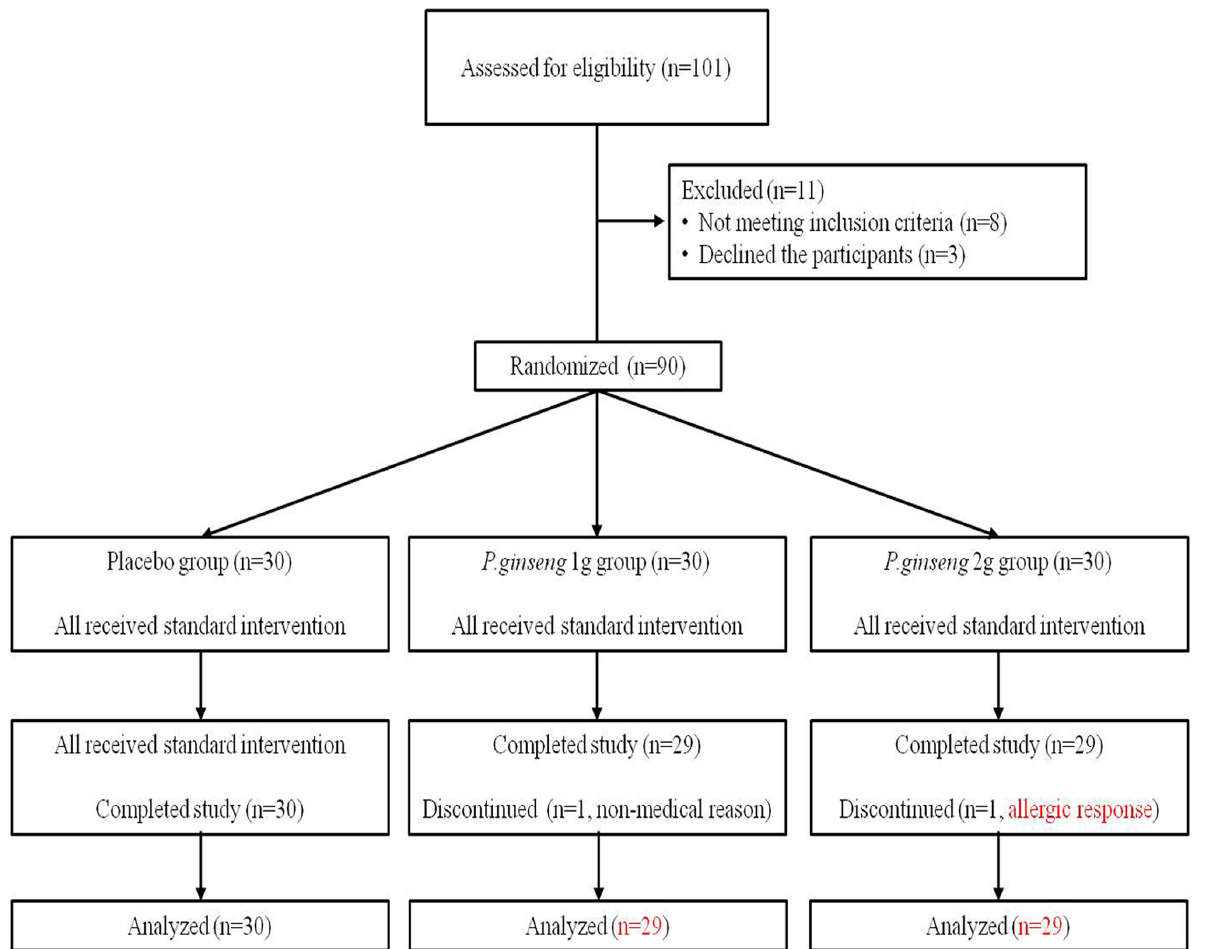
Figure 1. Flow diagram of subject progress through the phases of the RCT.